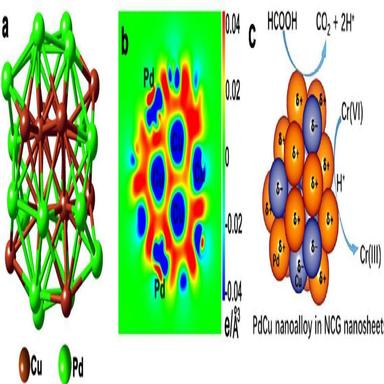
(a) Optimized PdCu nanocluster for modeling PdCu nanoalloy in NCG nanosheets, (b) Charge density difference image of PdCu alloy nanocluster, and (c) PdCu/NCG nanosheets catalysis for reducing Cr(VI) into Cr(III) by FA.